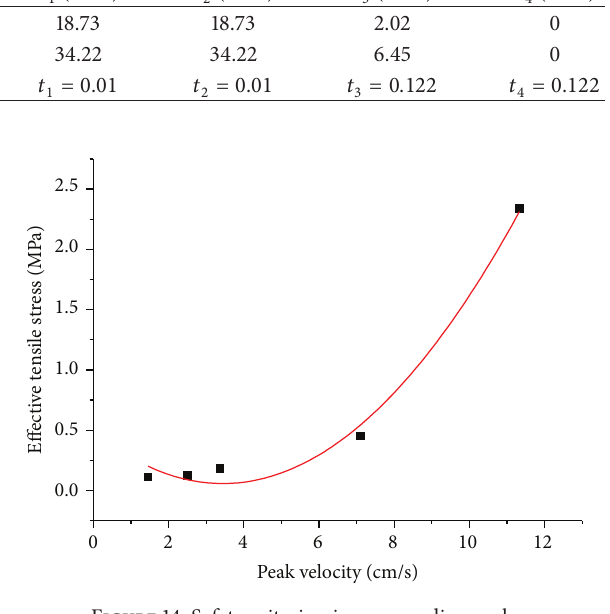
Figure 14: Safety criterion in surrounding rock.